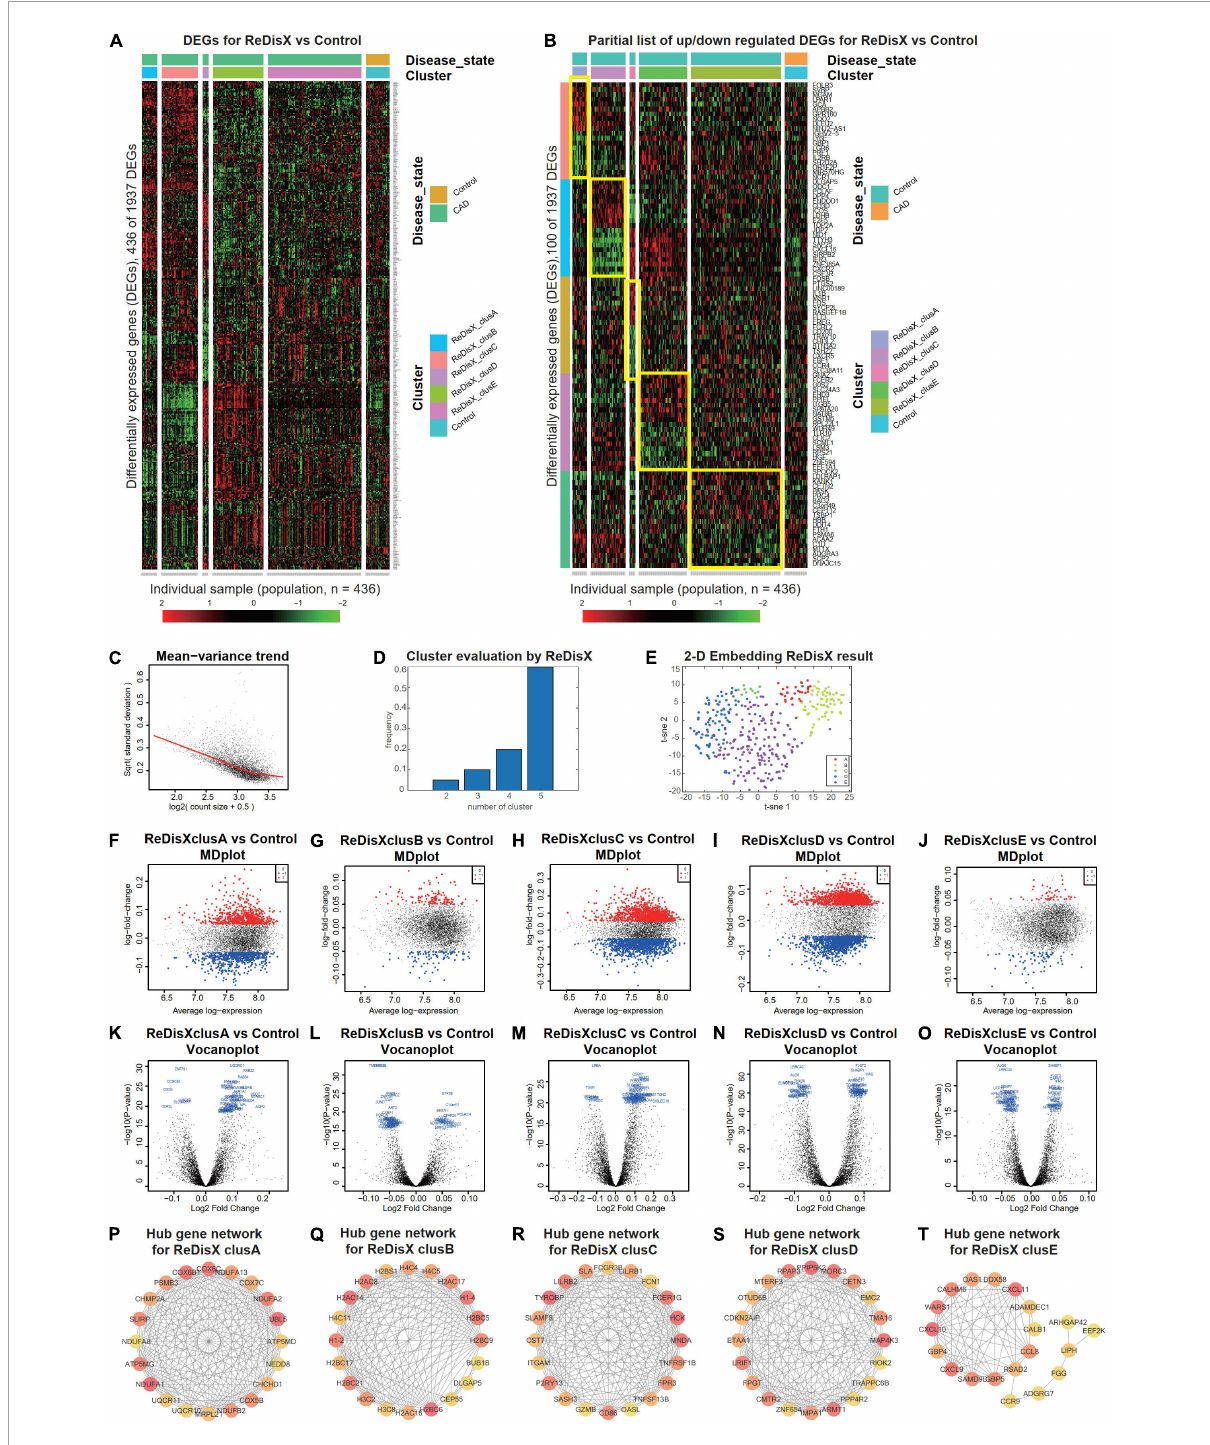
FIGURE4 ReDisX distinguishes the heterogeneous subpopulation among CAD patients. (A) Heatmap for relative expression in up/downregulating DEGs identified in GSE59867 ( p -value < 0.005, non-overlapping DEGs with other subpopulations). (B) Randomly selected 10 up-regulating genes and 10 downregulating genes correspond to each ReDisX-based cluster in GSE59867 ( p -value < 0.005, non-overlapping DEGs with other subpopulations). (C) Mean-variance trend after processed voom in GSE59867. (D) Optimal subpopulations from the total number of 390 CAD patients in GSE59867 by ReDisX. (E) PCA and t-SNE visualization of the total number of 390 patients in GSE59867. (F–J) MD plots for ReDisX-based clusters. The ReDisX-based cluster A (F) , cluster B (G) , cluster C (H) , cluster D (I) , and the cluster E (J) of the CAD patients to